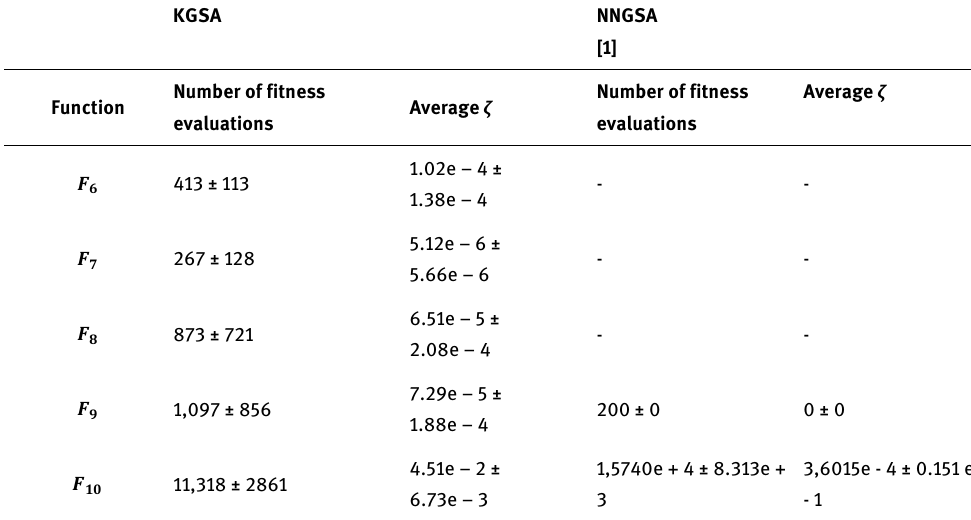
Table 9: Results of KGSA and NNGSA in terms of %ADR and the number of fitness assessments needed to converge for each niching algorithm using functions F 6 to F 10 . The results were averaged after fifty independent runs of